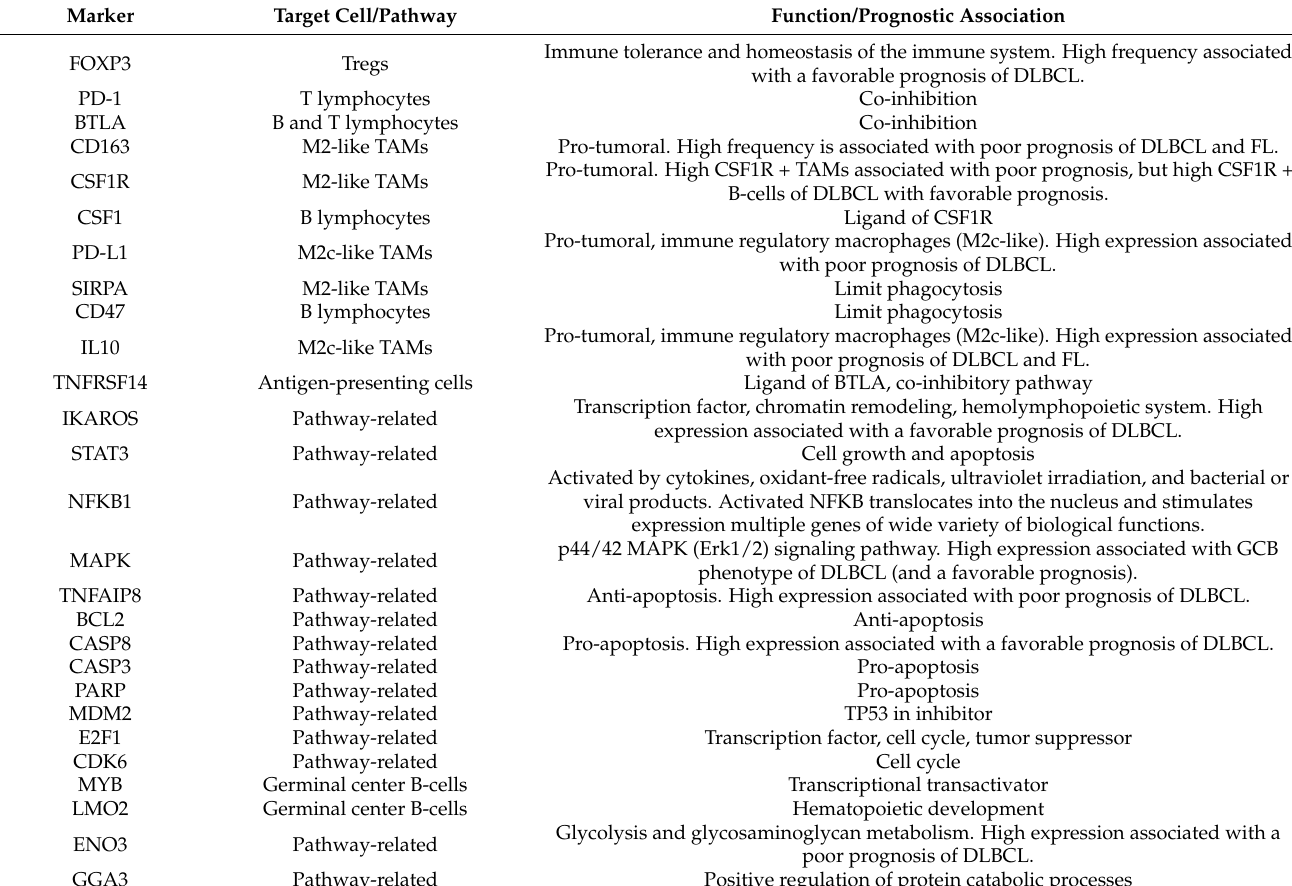
Table 3. Immuno-oncology and pathway-related markers that were highlighted in this